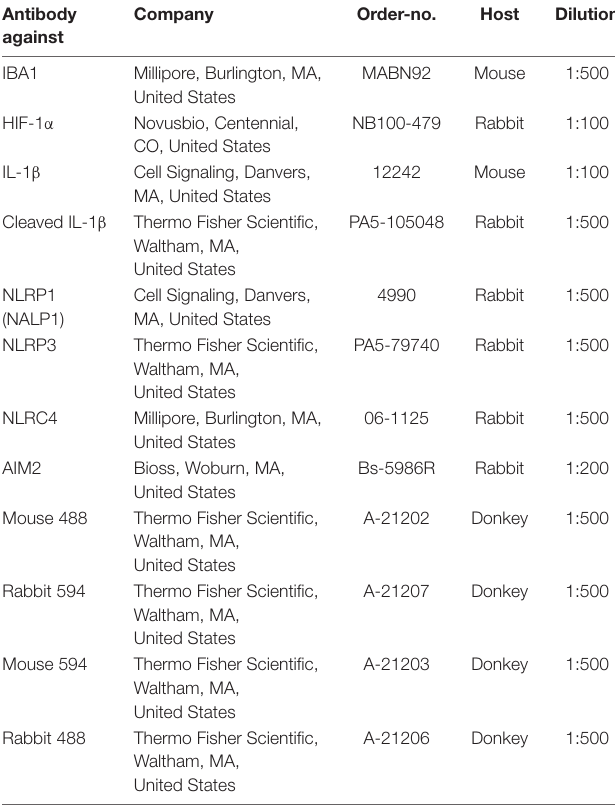
We utilized GraphPad Prism (version 8.4.3, San Diego, CA,